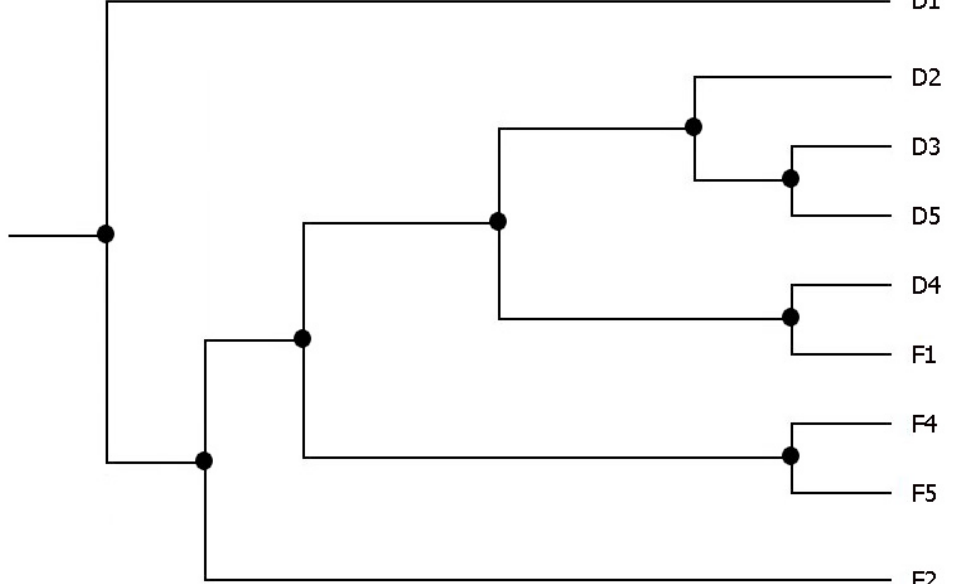
Figure S2. UniFrac clustering of fecal bacterial communities in domestic and feral goats. (Jackknifing node support represented by black circles) Excluding D1, an outlier, the fecal bacterial communities of domestic and feral goats largely cluster